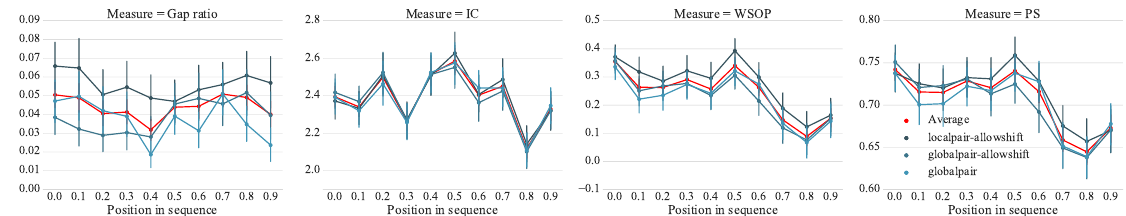
Figure 4. Position versus various stability scores (Information Content (IC), Weighted Sum-Of-Pairs (WSOP) and PS) for the T UNE F AM -26 dataset using three different alignment configurations. Position versus gap ratio is also presented (first to the left). Points are quantised to 10 bins.